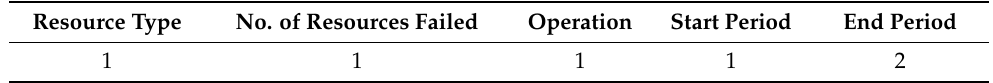
Table 4. Information of a Resource Failure.